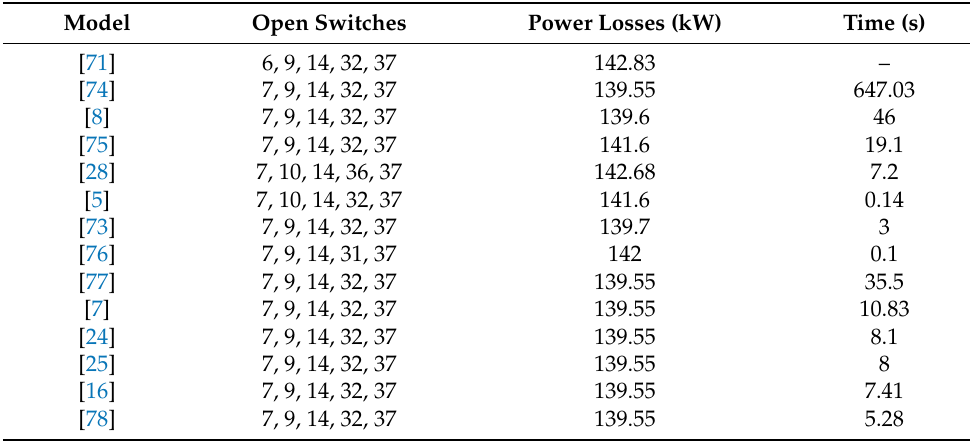
Table 12. Comparative analysis of the 33-bus test